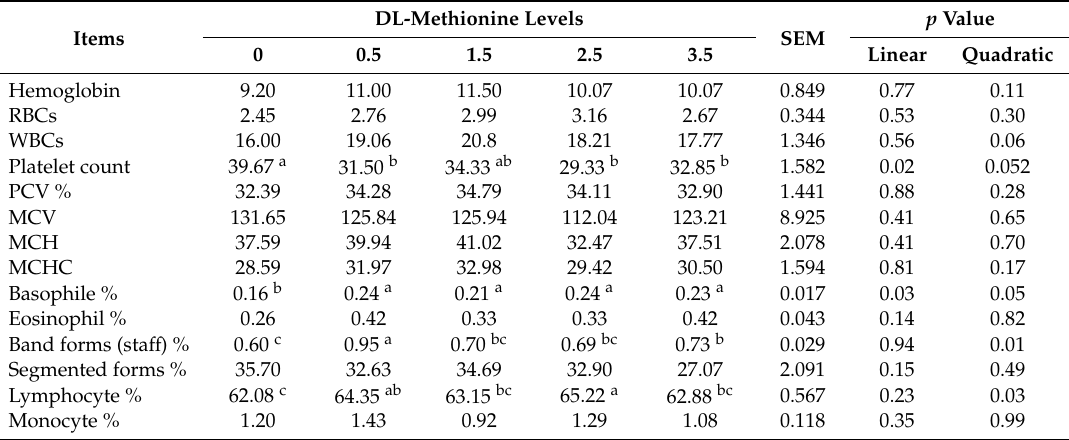
Table 5. Hematology of Japanese quail as a ff ected by dietary DL-methionine.